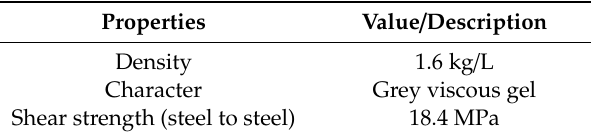
Table 2. Physical properties of the adhesive.